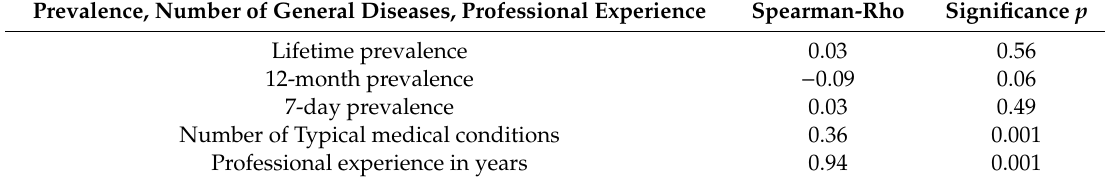
Table 6. Prevalence, number of general diseases as well as professional experience (in years) correlated by age. Prevalence, Number of General Diseases, Professional Experience